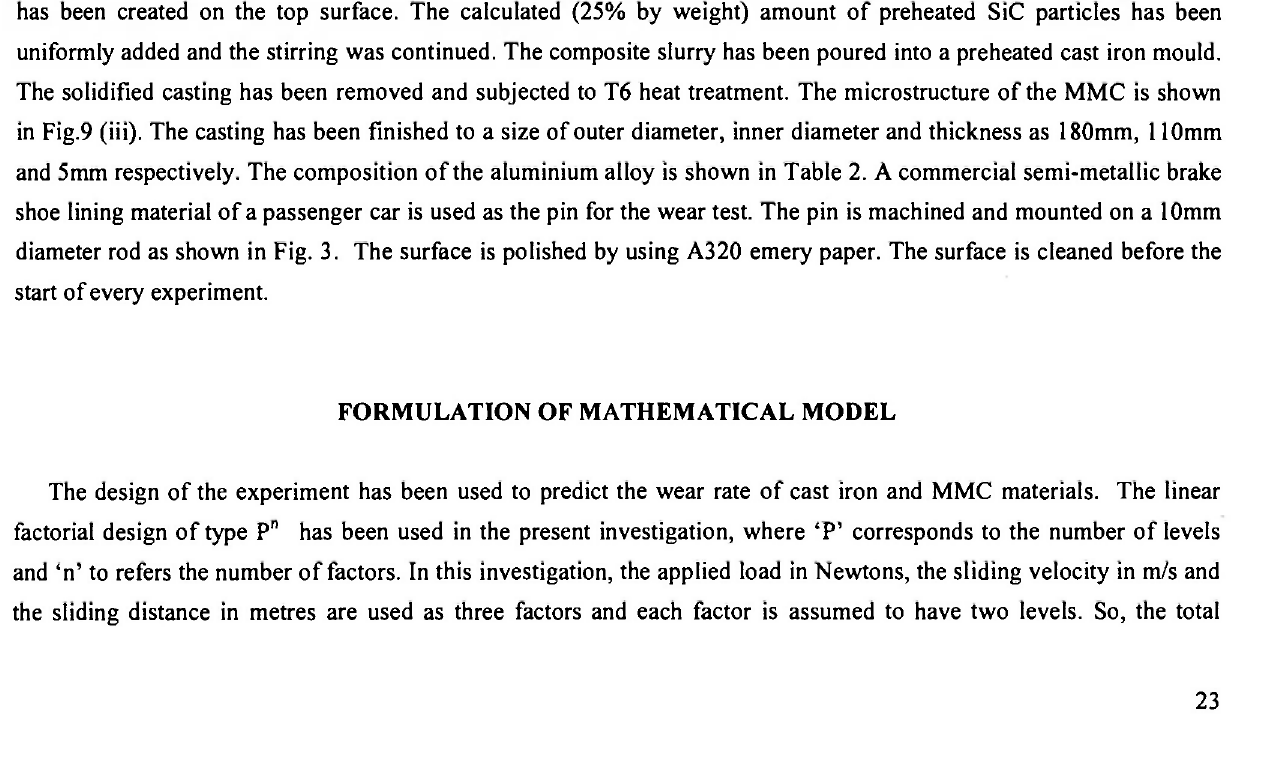
Composition of grey cast